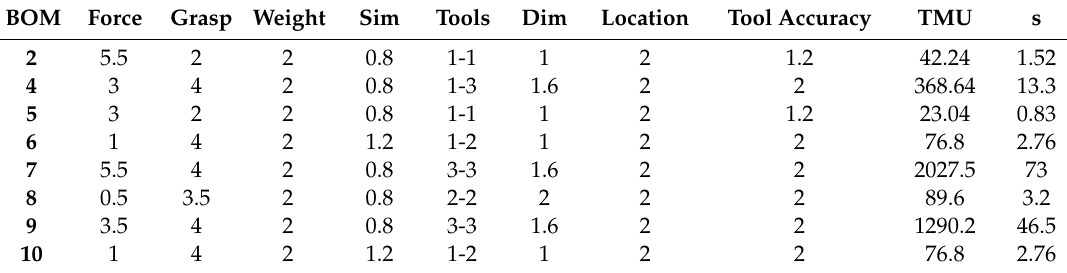
Table 3. Values obtained by Desai’s